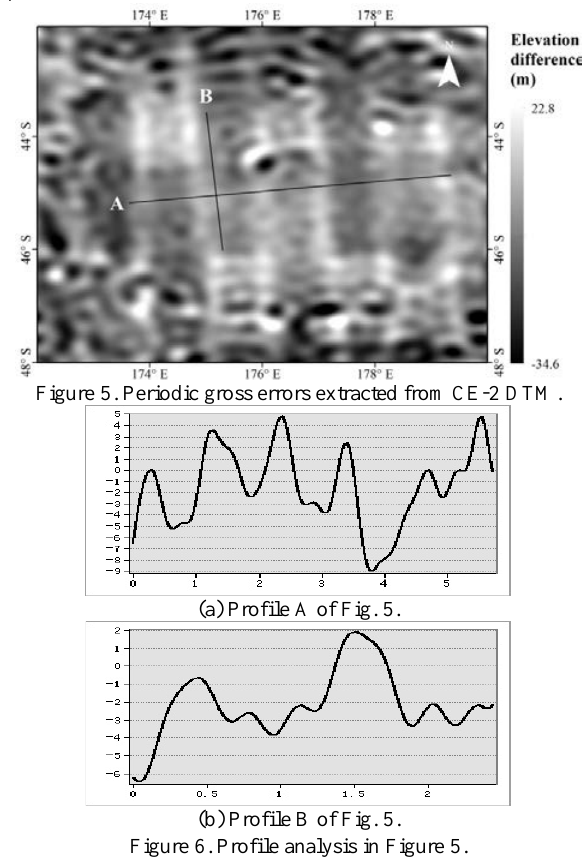
Figure 6. Profile analysis in Figure 5.